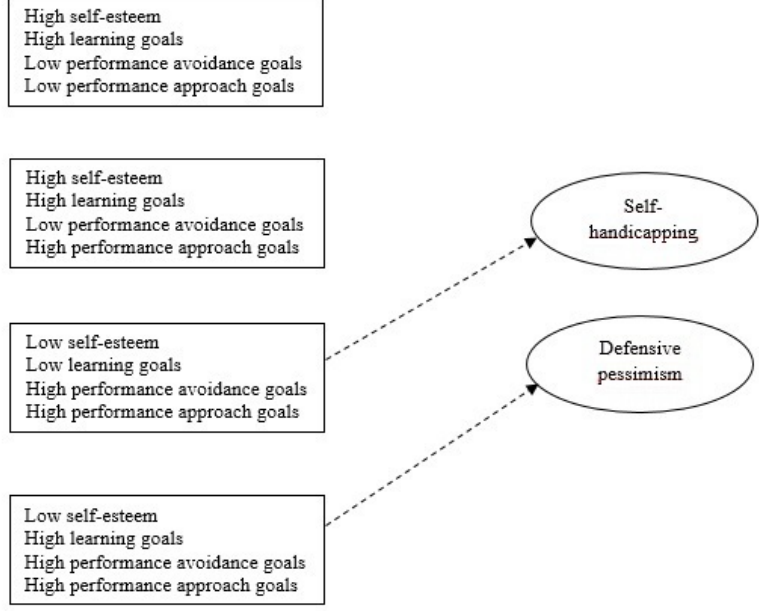
Figure 1. Hypothesized motivational profiles and expected associations to self-protection strategies.